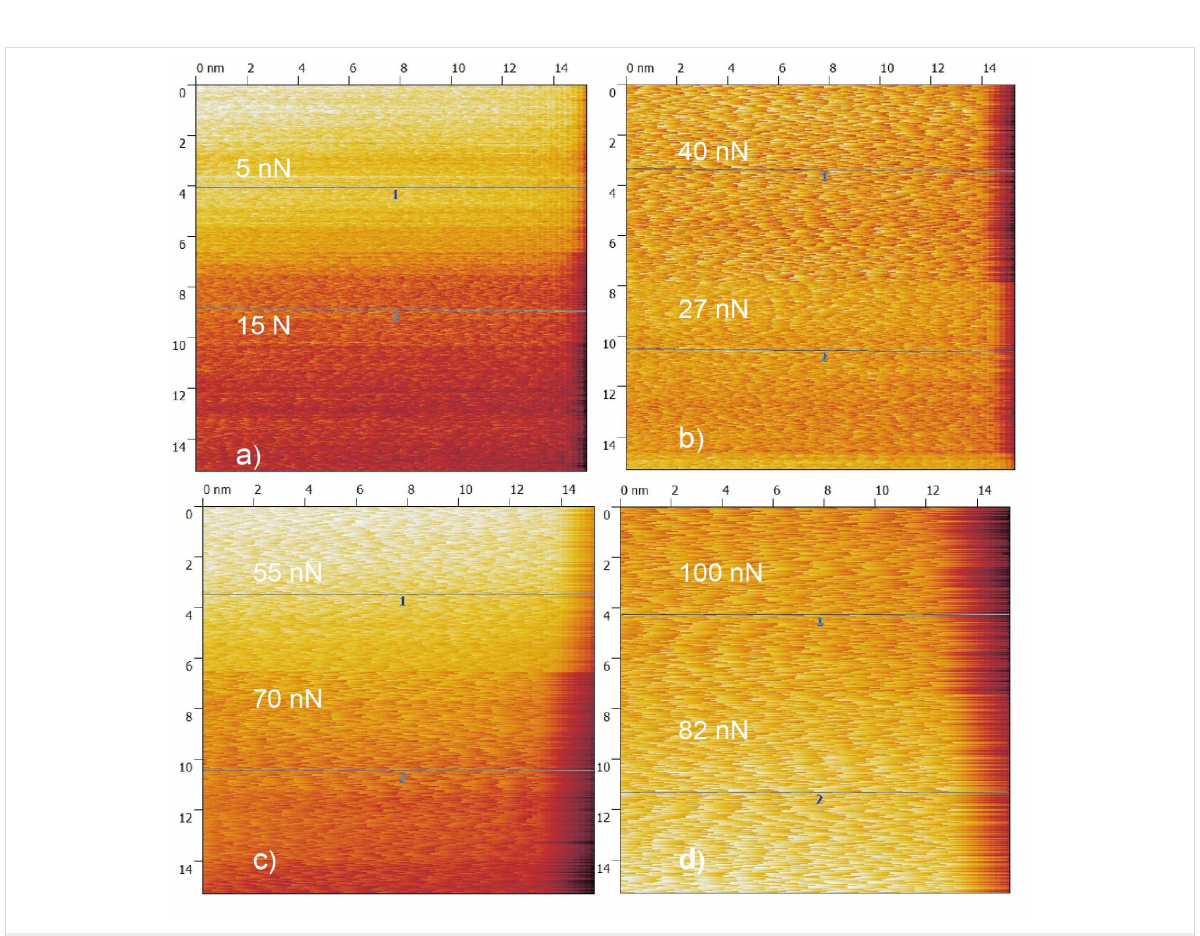
Figure 7: Copper monolayer friction images at F N = a) 5, 15 nN; b) 27, 40 nN; c) 55, 70 nN and d) 82, 100 nN.